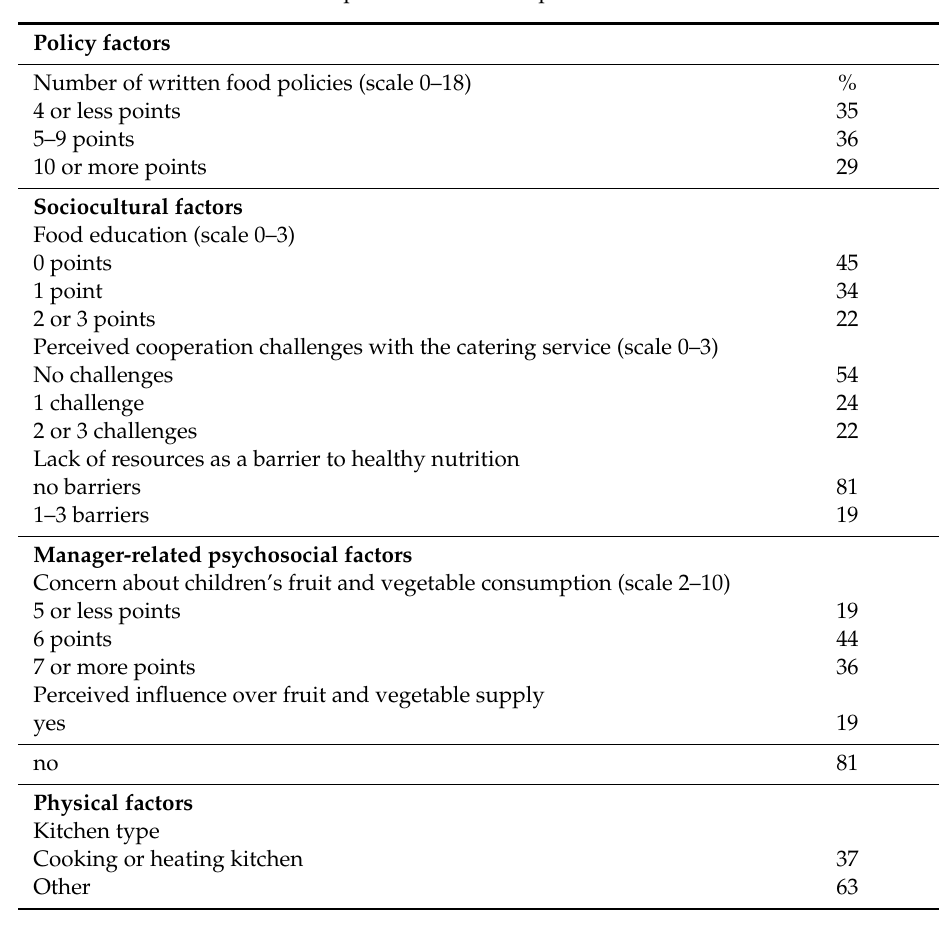
Table 2. Descriptive results on the preschool-level